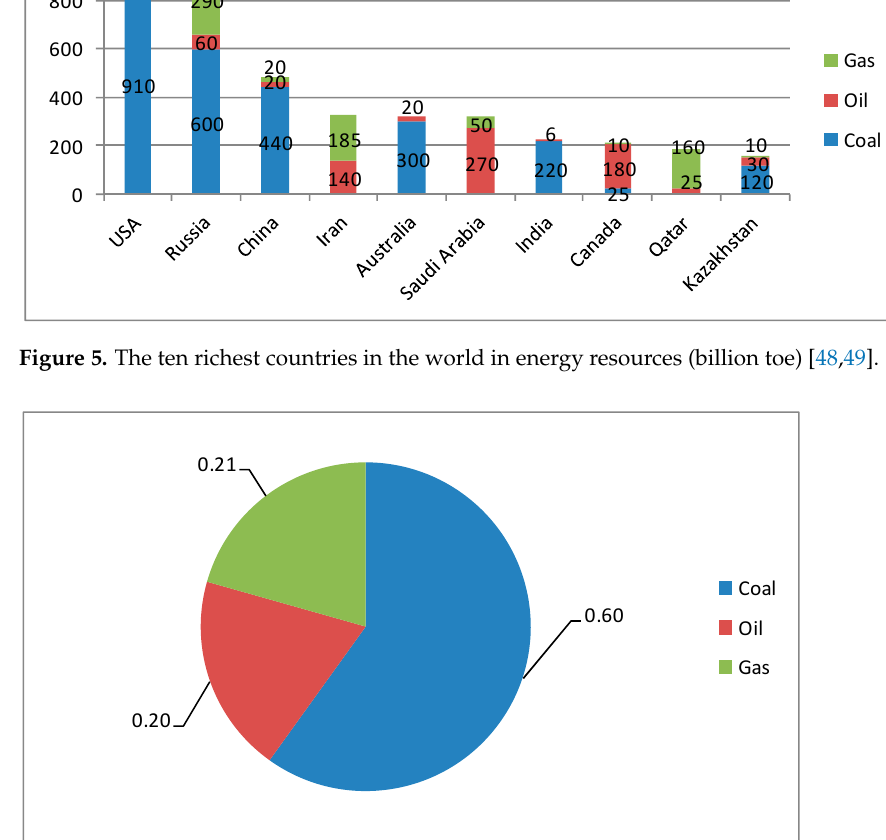
Figure 6. World resources of the three main energy raw materials (in terms of percentage) [41].